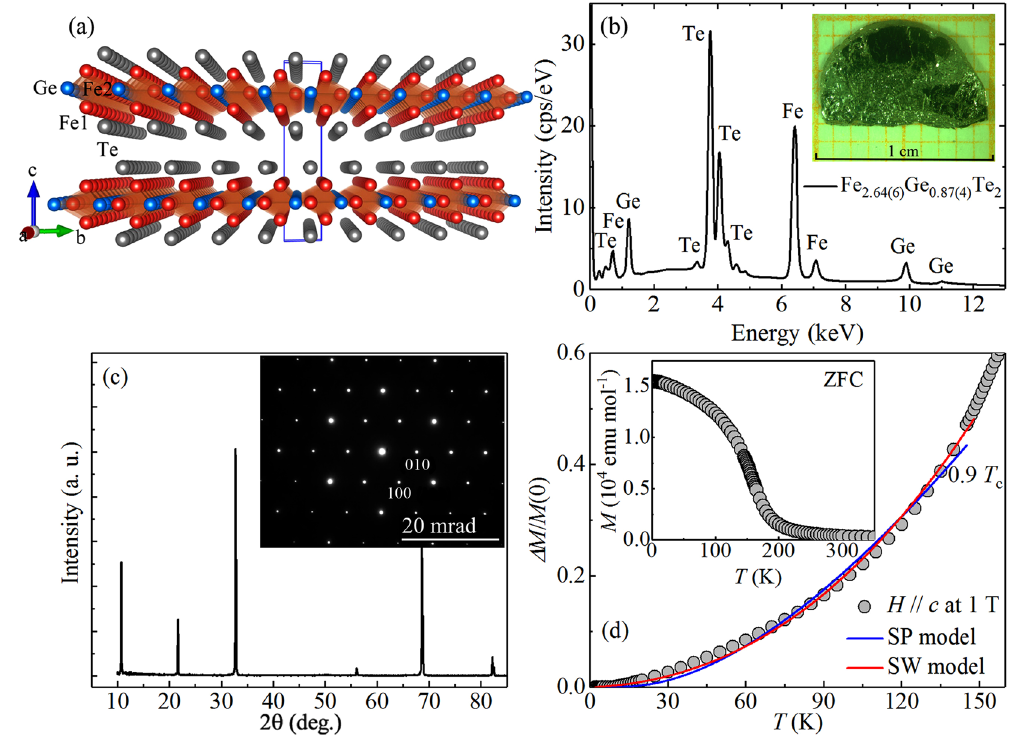
Figure 1. ( a ) Crystal structure and ( b ) X-ray energy-dispersive spectrum of Fe 3 − x GeTe 2 single crystal. Inset shows a photograph of Fe 3 − x GeTe 2 single crystal on a 1 mm grid. ( c ) X-ray diffraction (XRD) pattern of Fe 3 − x GeTe 2 . Inset shows the electron diffraction pattern taken along the [001] zone axis direction. ( d ) Temperature dependence of the reduced magnetization with out-of-plane field of Fe 3 − x GeTe 2 fitted using spin- wave (SW) model and single-particle (SP) model. Inset shows the temperature dependence of zero-field-cooling (ZFC) magnetization of Fe 3 − x GeTe 2 measured at H = 1 T applied along the c